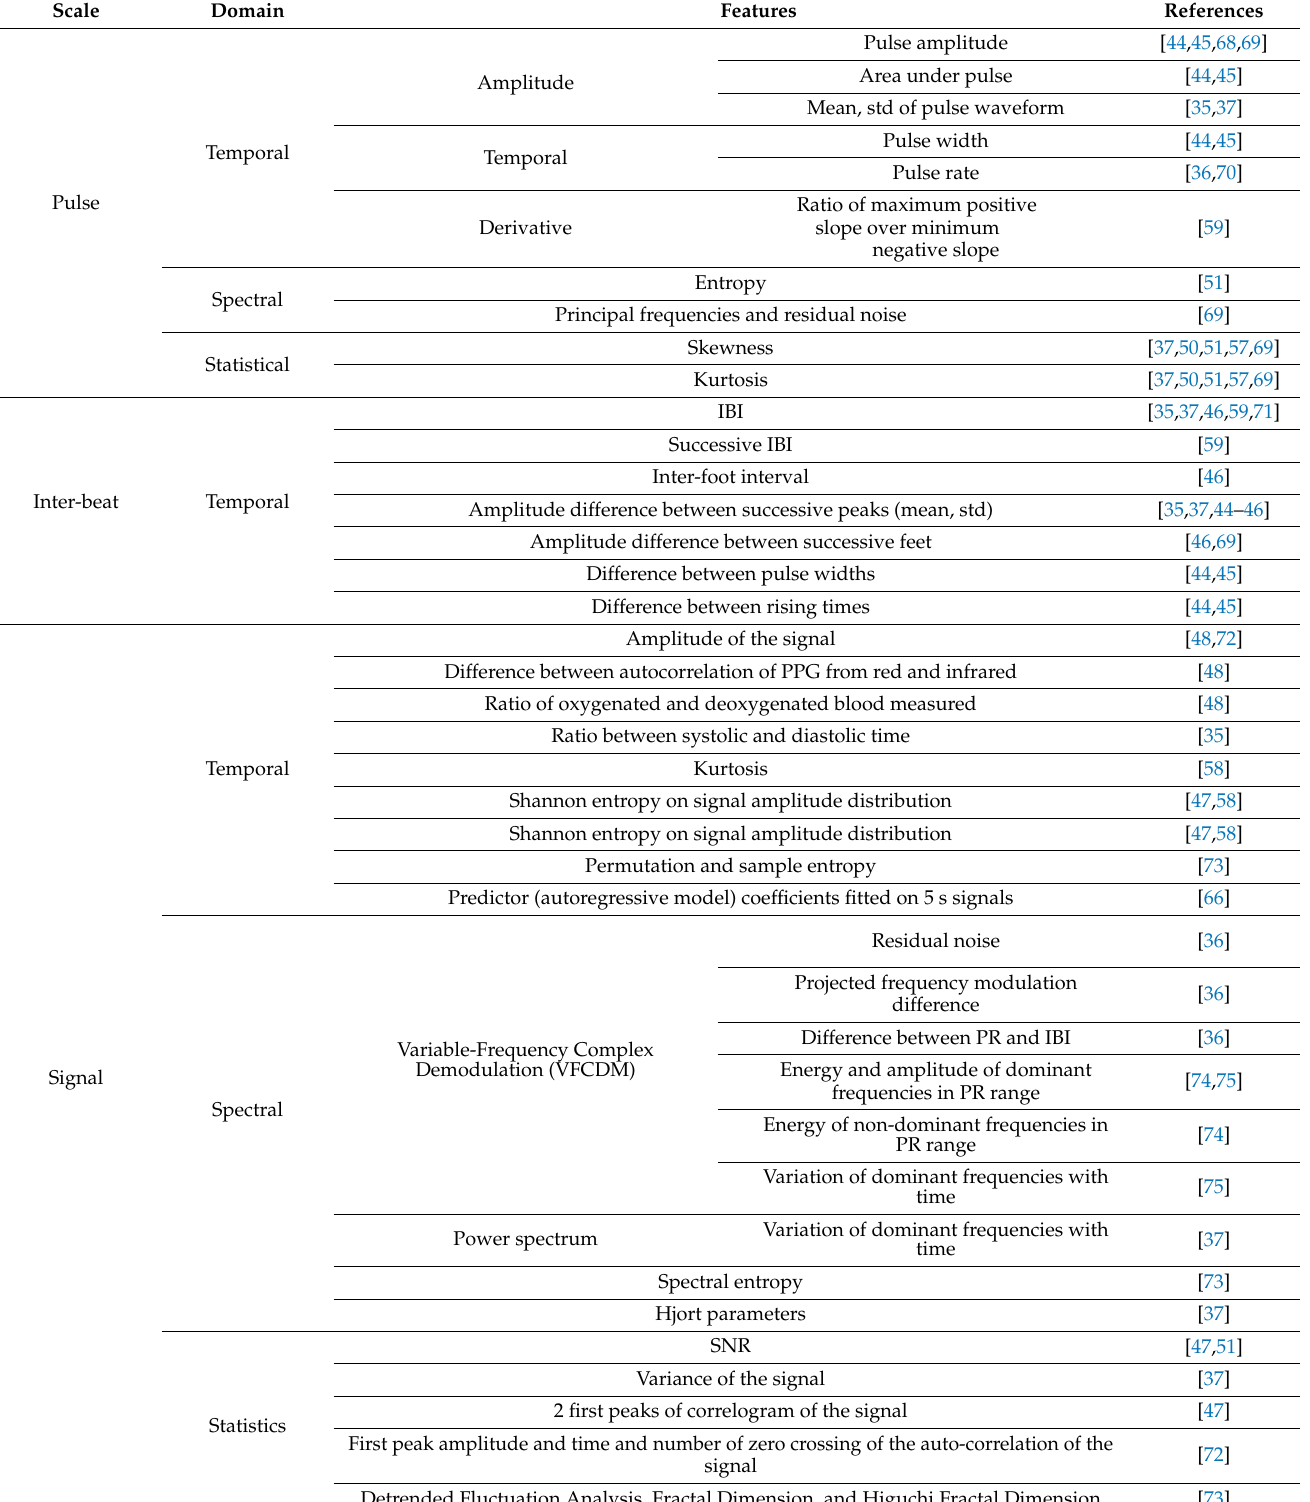
Table 4. Enumeration of the different PPG signal features extracted for the assessment of its